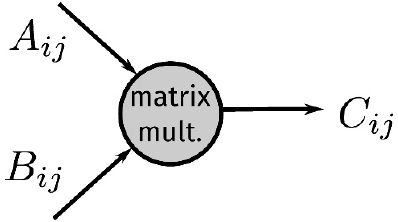
Figure 4 . A node representing the matrix multiplication C ij = P lists with the matrix elements A ij , B ij and C ij in row-major order. Their number of rows and columns is de(cid:12)ned when the node is